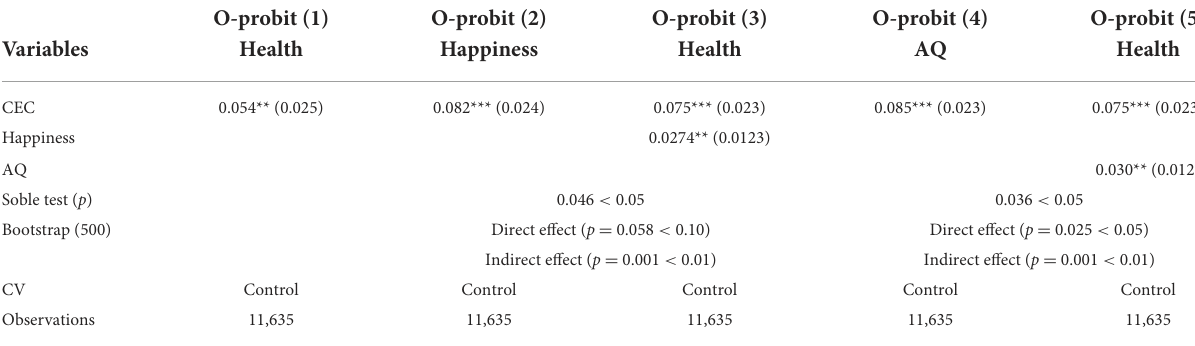
TABLE 7 The results of mediating effect of CEC, happiness and AQ on health.